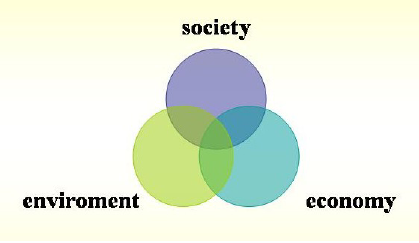
Fig 1. Conventional approach to